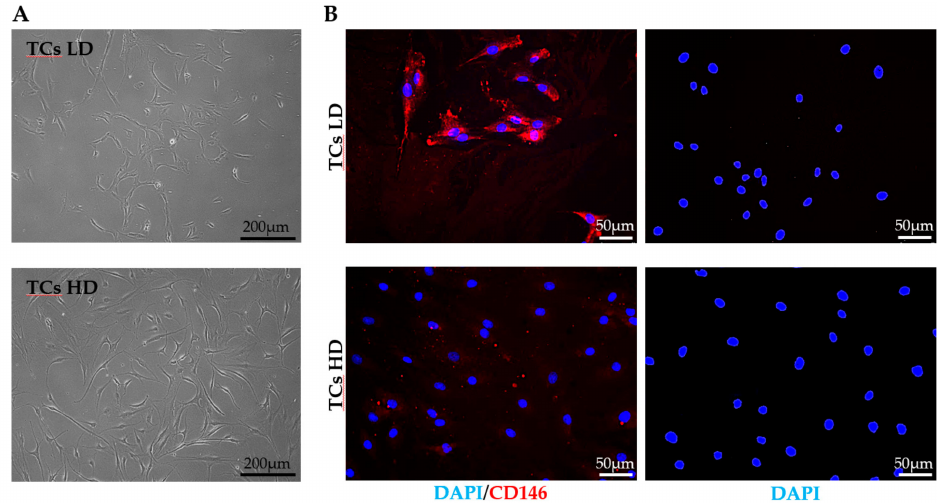
Figure 1. Tendon cells’ (TCs) morphology and CD146 expression. ( A ). Representative bright-field pictures of low-density (LD) and high-density (HD) TCs. ( B ). Immunofluorescence staining of LD and HD TCs for CD146 (red) and DAPI (blue). Negative control samples were subjected to overnight incubation at 4 ◦ C with blocking bu ff er without the primary